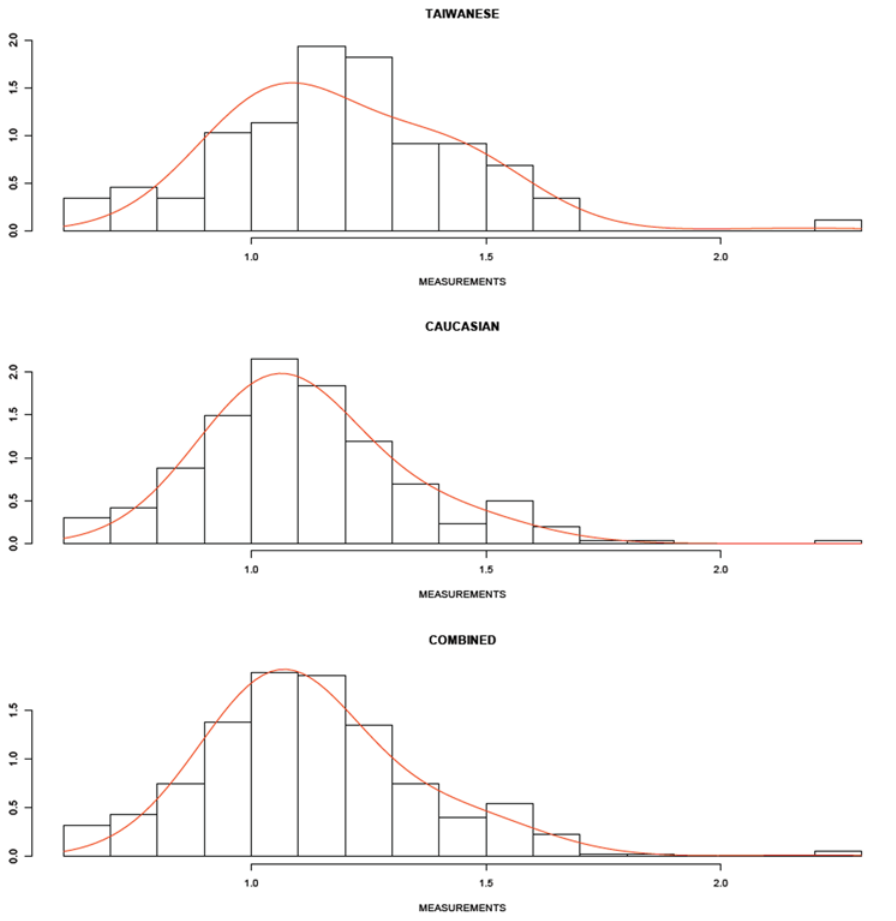
Figure 3. In these figures, we provide histograms of P4077 probe ratio data for Taiwanese, Caucasian and Combined (Taiwanese and Caucasian) samples. We also provide a fitted probability density function line for each data set. These graphs were created using the R programming environment. The horizontal axis labeled ‘‘MEASUREMENT’’ refers to each individual’s probe ratio data value (after log transform) for the P4077 probe.